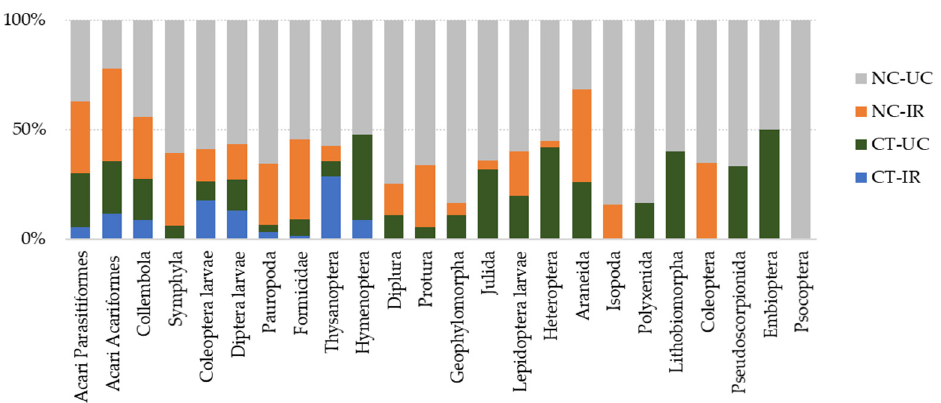
Figure 4. Relative frequency histogram showing the proportion of each soil arthropod group occupy-